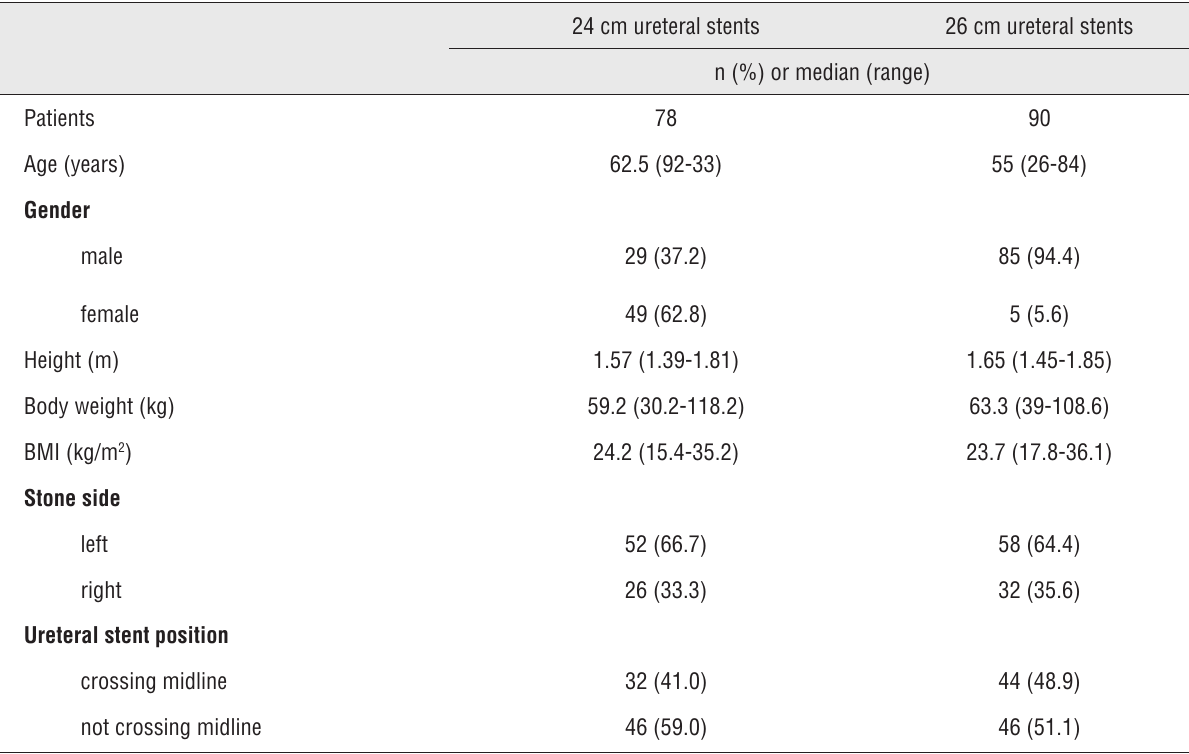
Table 1 - The demographic data of patients with indwelling 24-cm and 26-cm ureteral stents. 24 cm ureteral stents 26 cm ureteral